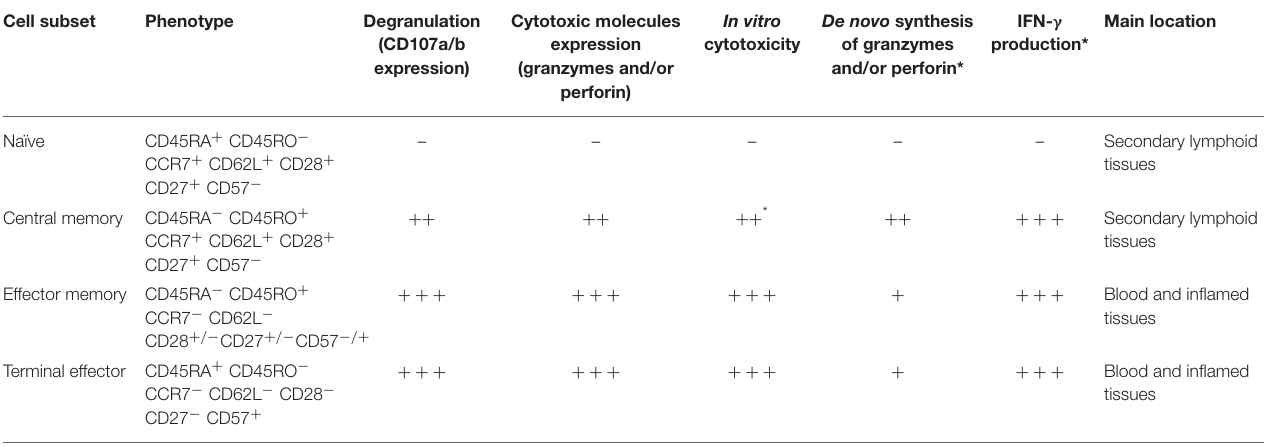
TABLE 1 | Effector capacity of CD8 + T-cells according to their differentiation